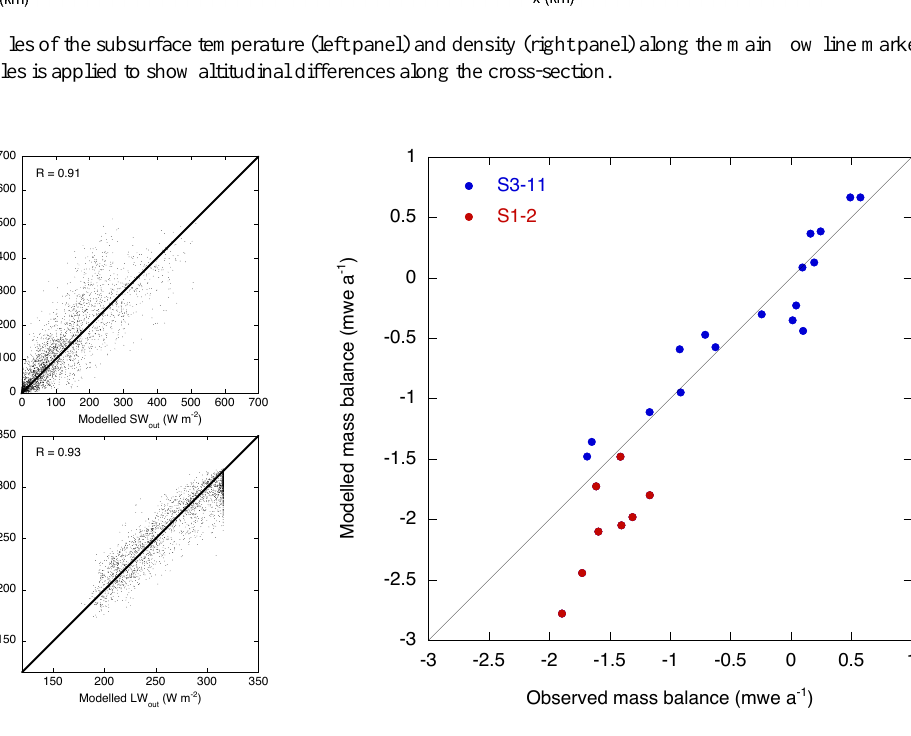
Fig. 12. Scatter plot of simulated mass balance values versus mass balance estimates derived from stake height observations over the period 2006–2010 at sites